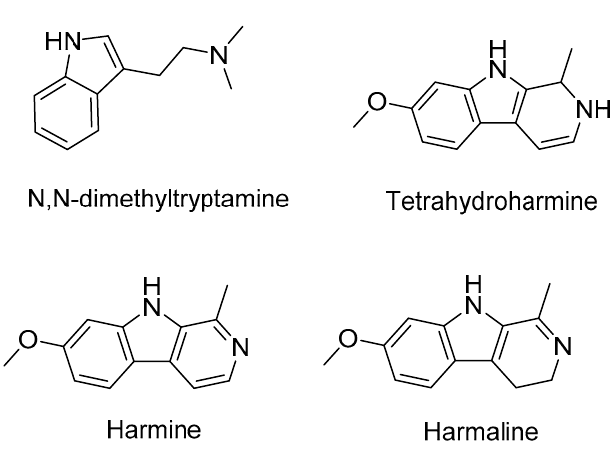
Figure 1. Chemical structures of the main ayahuasca alkaloids.